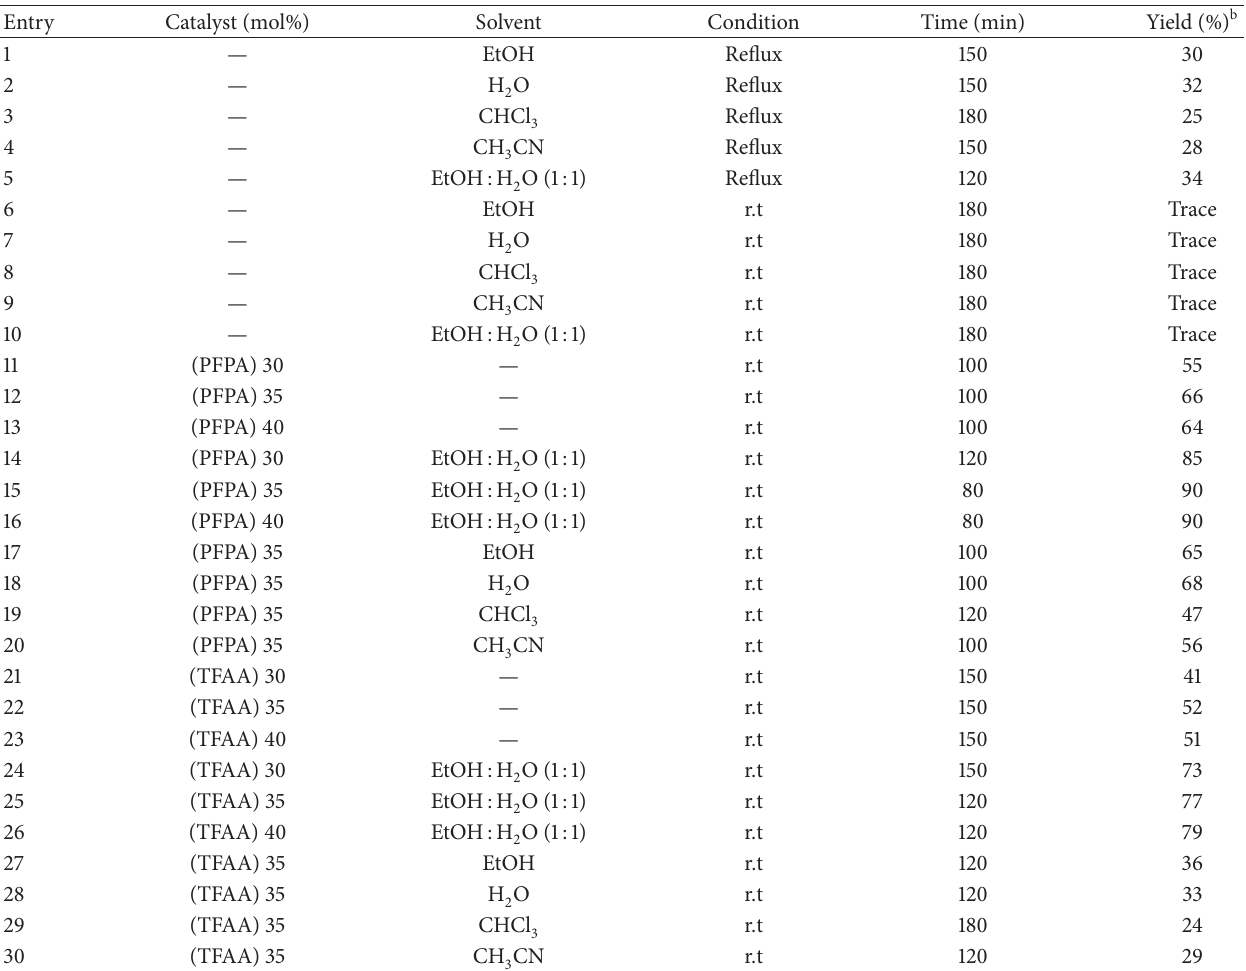
Table 1: Optimizing the reaction conditions a